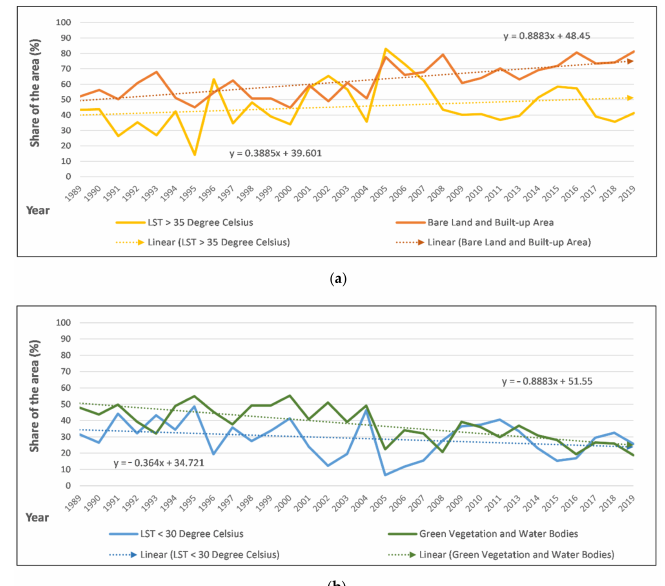
Figure 10. Change trends for LST range and land-cover by classes from 1989 to 2019. ( a ) Share of are with LST > 35 ◦ C vs. share of area with Bare Land and Built-up Area, ( b ) Share of are with LST < 35 ◦ C vs. share of area with Green Vegetation and Water